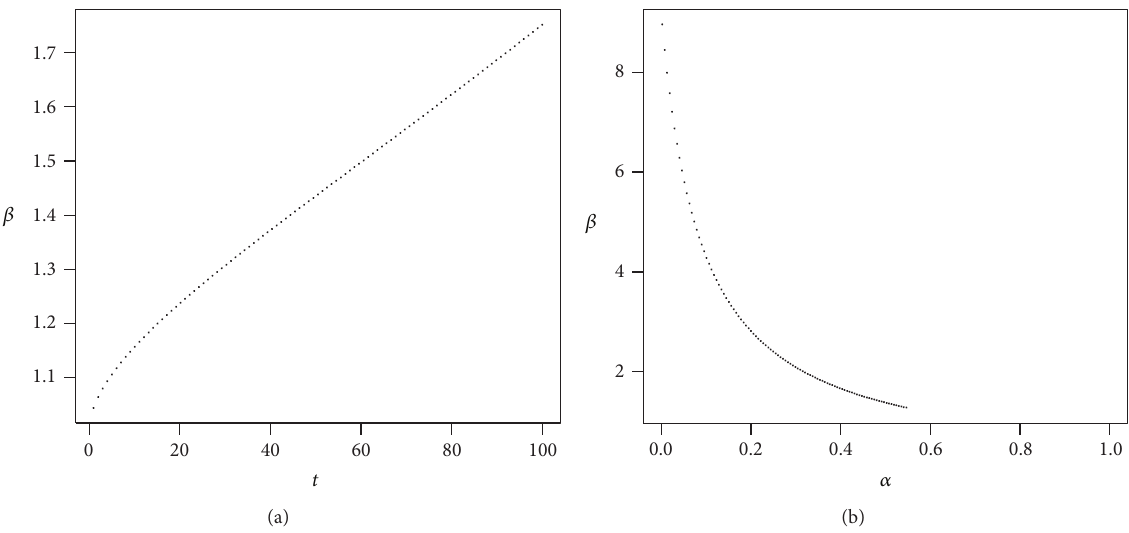
Figure 5: Medium volatility of returns (pessimistic). The plot shows 𝛽 as a function of 𝑡 with 𝛼 = 50 % (a) and 𝛽 as a function of 𝛼 with 𝑡 = 40 (b). Parameters are 𝑟 = 4 %, 𝜇 = 8.5 %, 𝜎 = 25 %, ] = 1.1 %, and 𝛾 = 10 %.